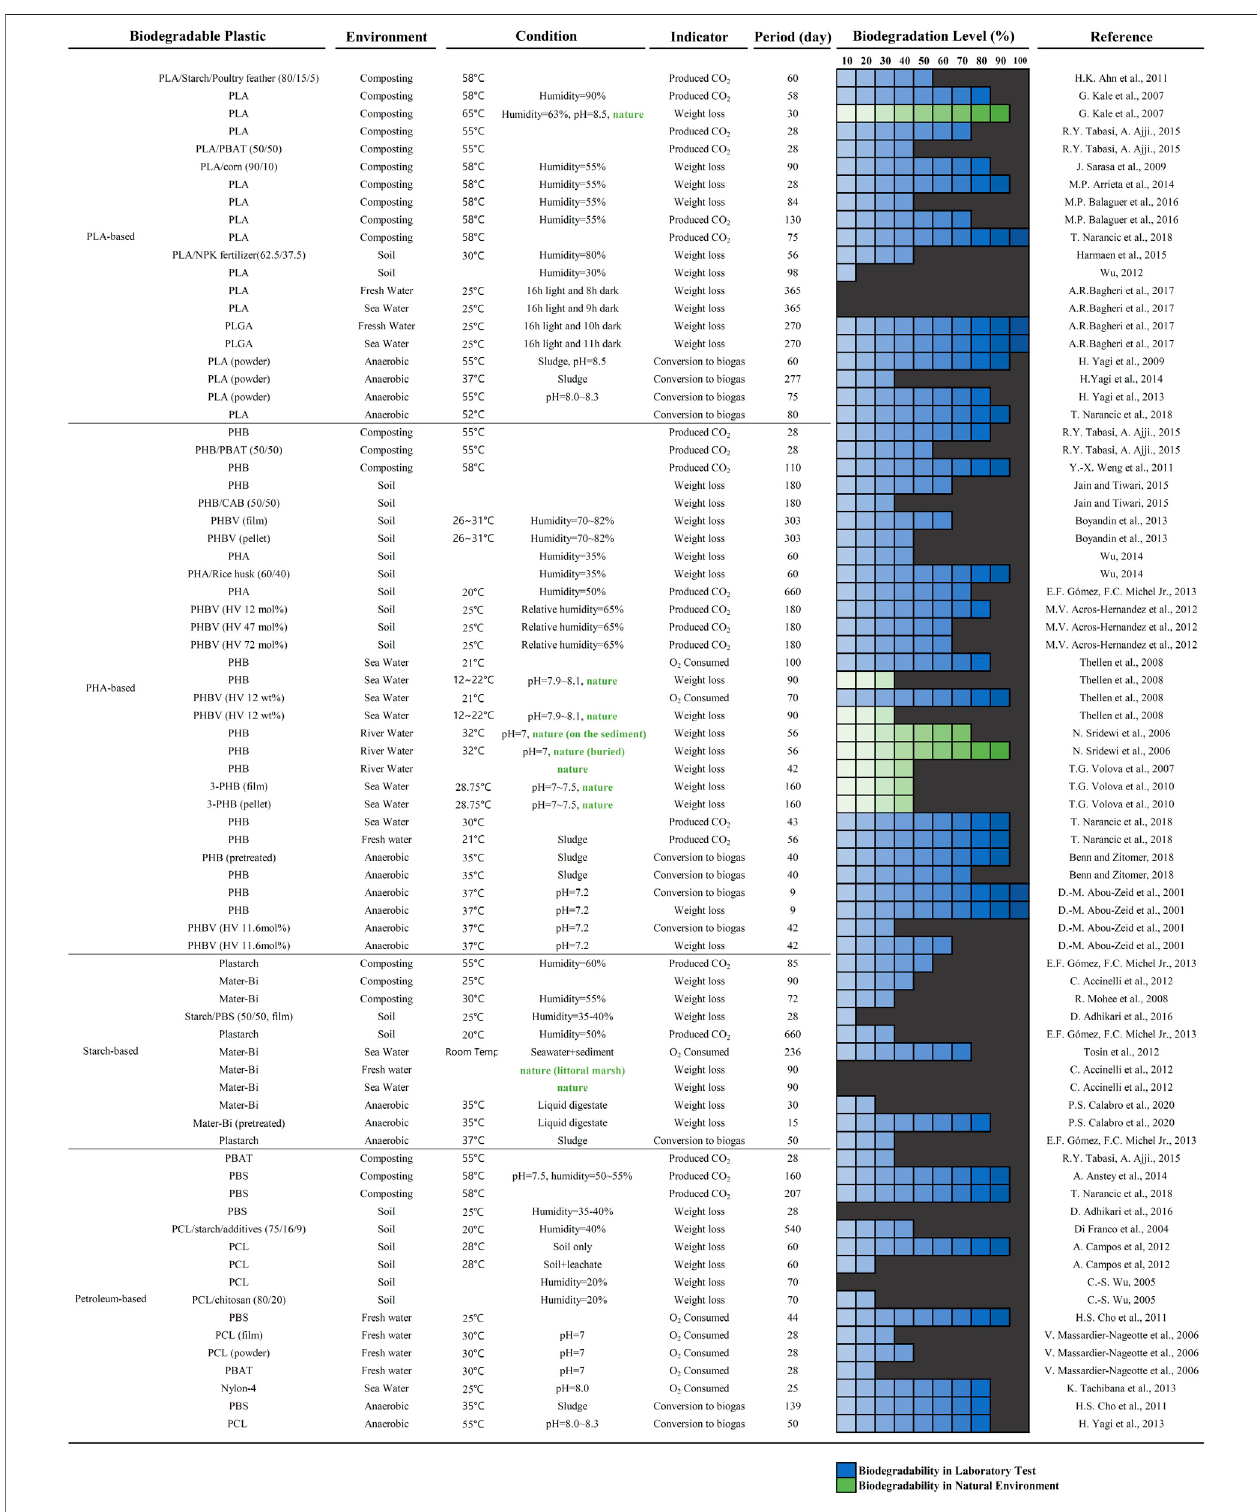
FIGURE 1 | Biodegradation study results of biodegradable plastics in the laboratory (blue) and in the natural environments (green), selected by the authors. The comprehensivebiodegradationdataareavailableinthesupplementarymaterial( SupplementaryTableS2 ).Notethattheanalyticalanalysis(averaging)wasconducted based on the supplementary data